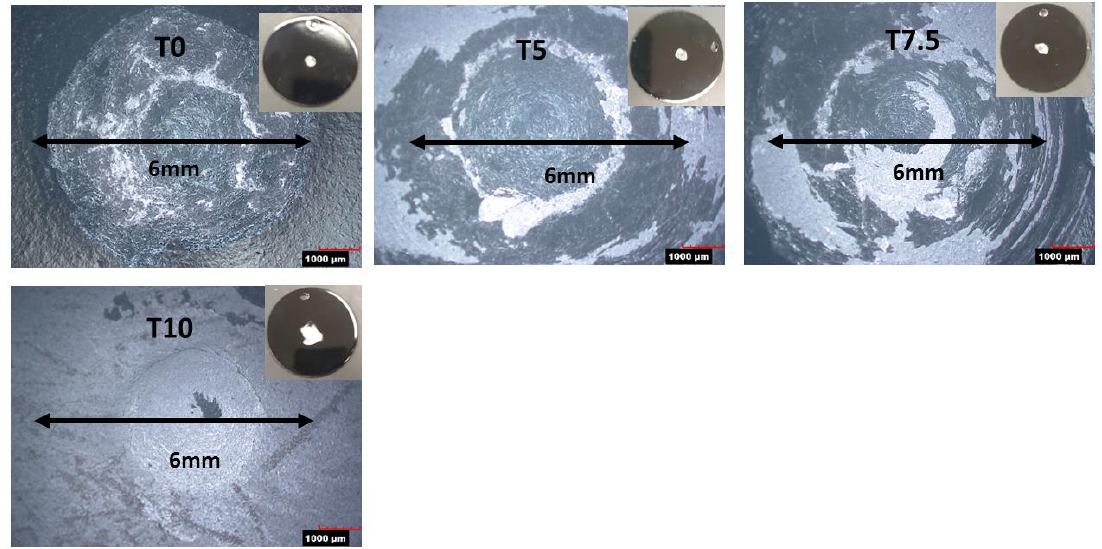
Figure 5. Micro-photographs of the impact centers of the enamel coatings of samples T0, T5.0, T7.5 and T10.0 after the impact test.